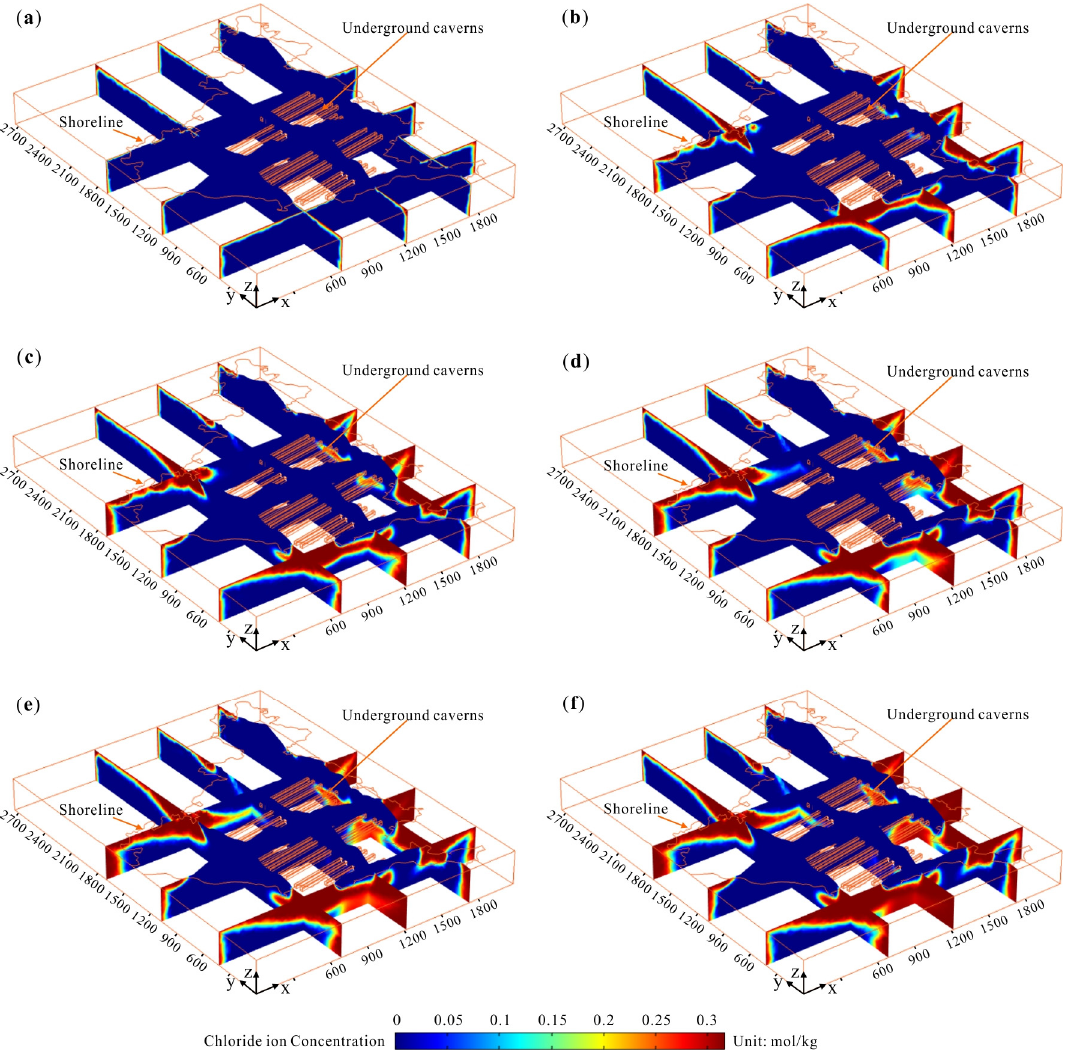
Figure 14. Temporal-spatial variations of seawater intrusion: ( a ) 0 year; ( b ) 10 years; ( c ) 20 years; ( d ) 30 years; ( e ) 40 years; ( f ) 50 years.